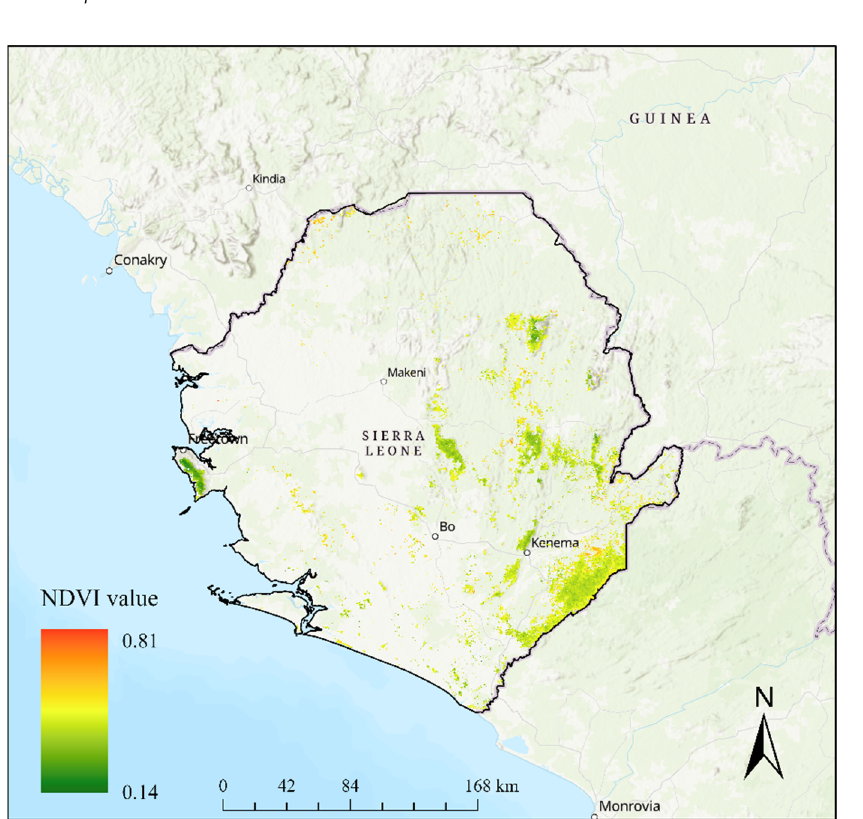
Figure A1. Mean NDVI values of forests during the growing season from June to August averaged from 2001 to 2015. Table A1. Causal effect of agricultural aid on forests with control variables of temperature and pre- cipitation.